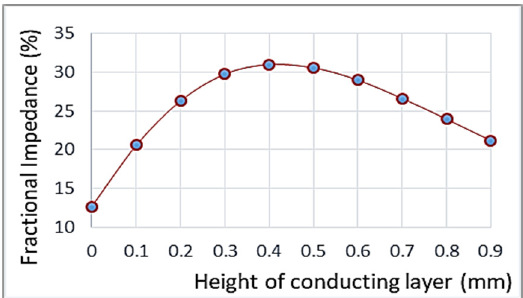
Fig.7: Fractional impedance of the epithelial layer compared to the whole tissue as a function of the height of conducting layer. Edge-edge electrode separation is 1